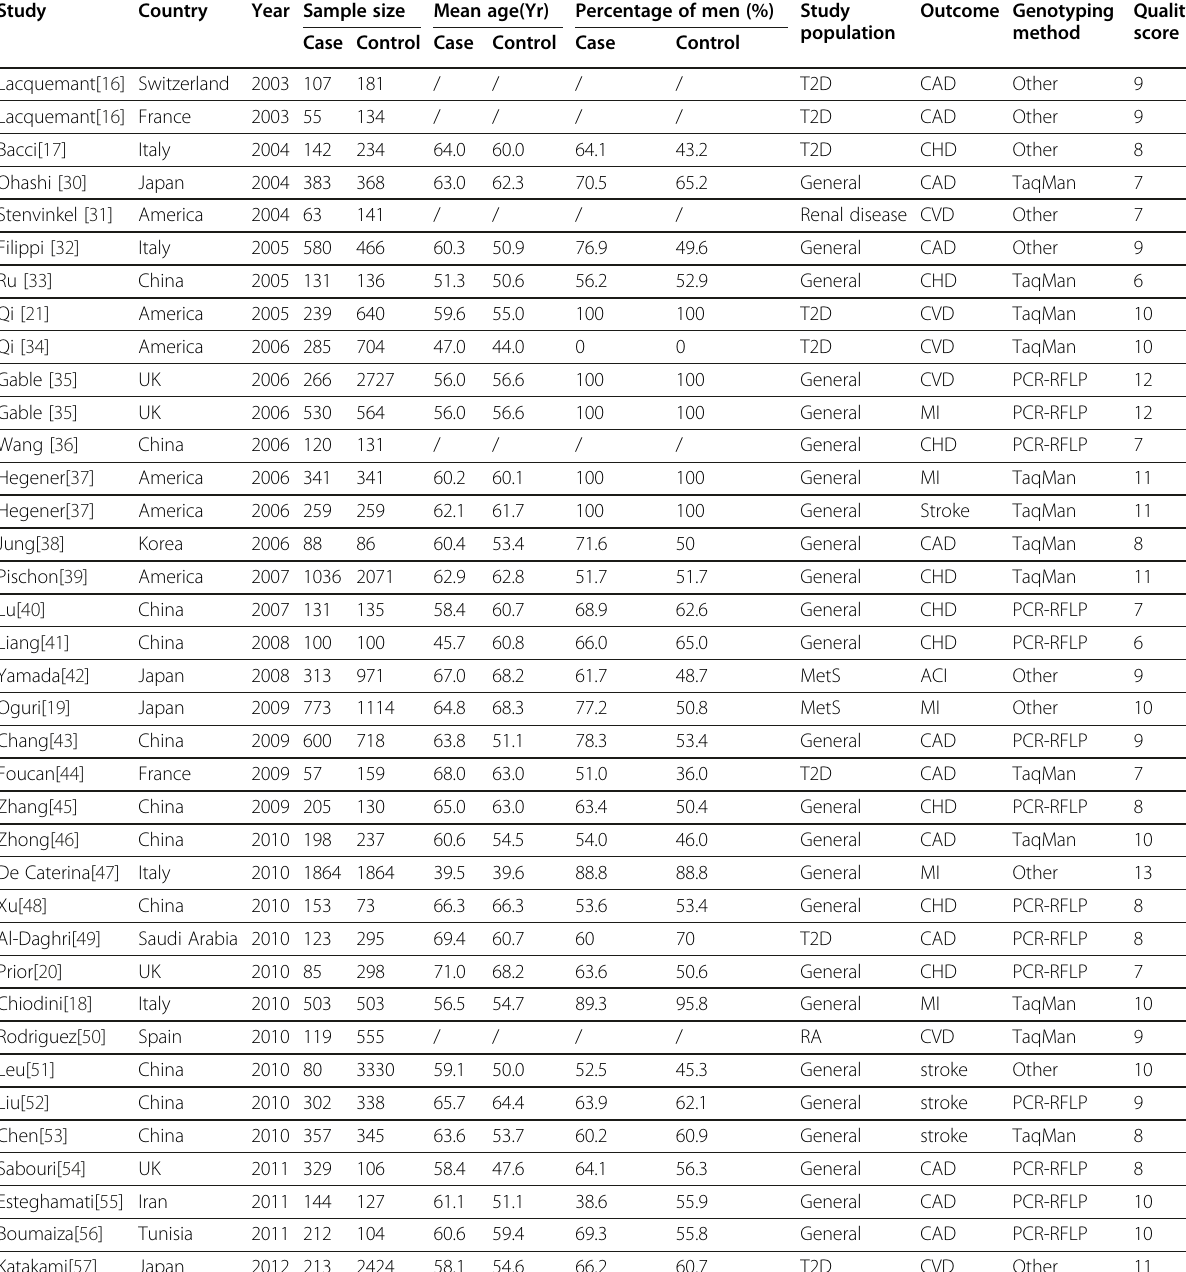
Table 1 Characteristics of the eligible studies included in the meta-analysis Study